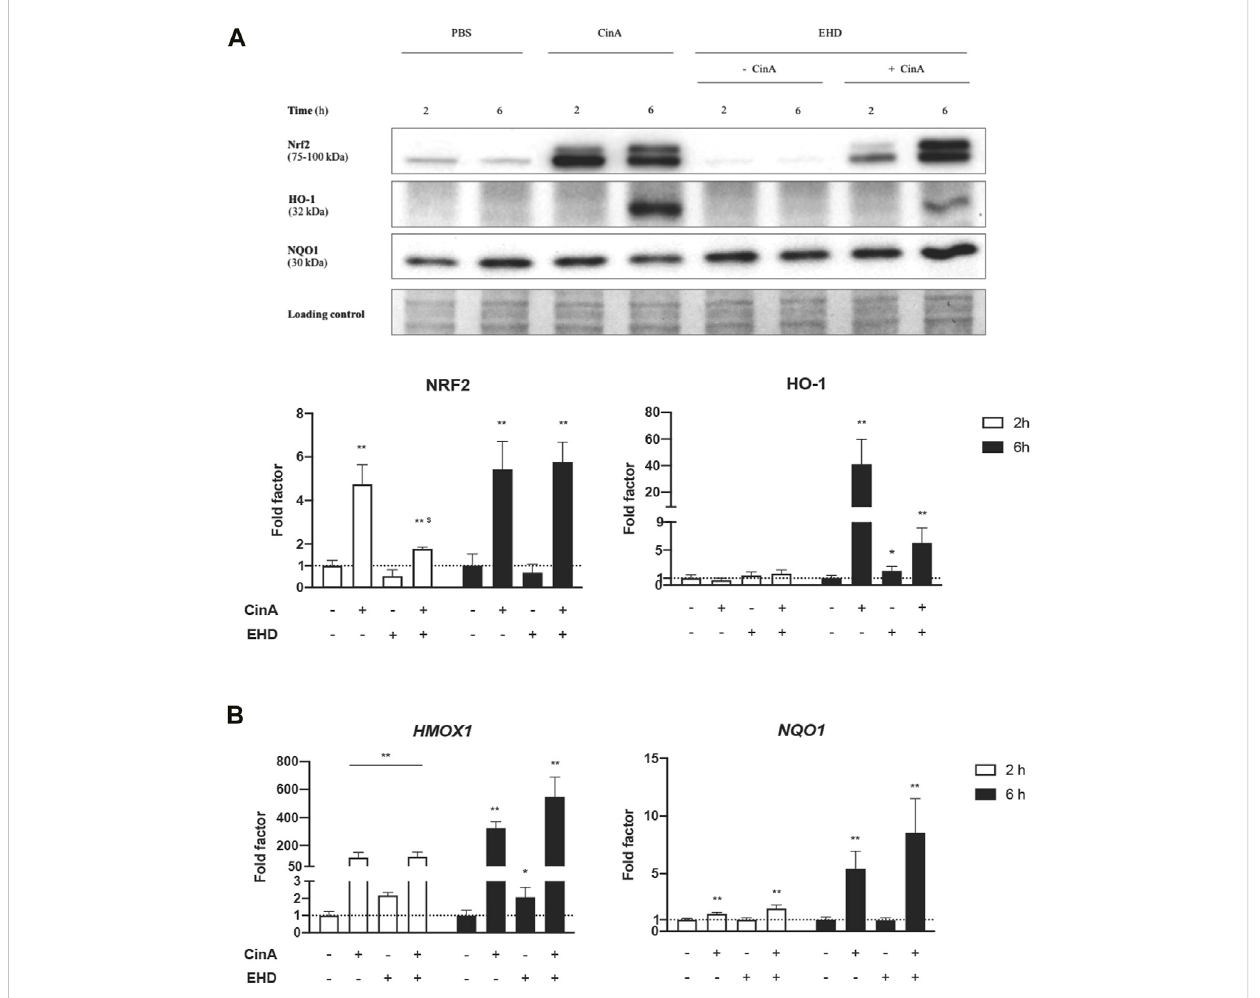
FIGURE 1 EHD does not induce the NRF2 pathway in KERTr cells . KERTr cells were treated for 2 and 6 h with CinA (100 μ M), EHD (10 μ M), a mixture containing CinA and EHD at the same concentrations, and PBS (0.1%) as vehicle control. (A) Effect of EHD on the expression of proteins of the NRF2 pathway. After treatment, protein expression of NRF2, HO-1, and NQO1 were quanti fi ed by Western blot with the Imagelab software (Bio-Rad). (B) Effect of EHD on the expression at gene level of two NRF2-dependent-ARE-responsive genes, HMOX1 and NQO1 . After treatment, the genic expression of HMOX1 and NQO1 werequanti fi ed by RT-qPCR. Results are expressedas the mean ± SEM of three duplicated independent experiments. * indicates signi fi cant differencesfrom untreatedcontrol cells atthesametime ofstimulation (Mann-Whitney test, ** p ≤ 0.05 and * p ≤ 0.1), and$indicates signi fi cant differences between CinA and the mixture at the same time of stimulation (Mann-Whitney test, p ≤